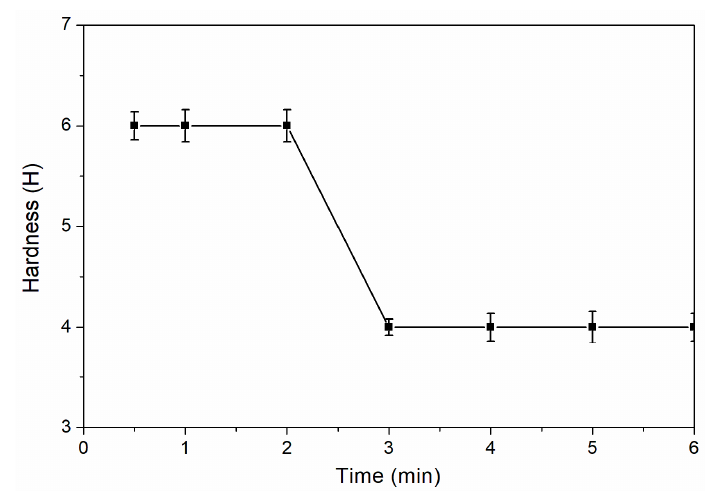
Figure 5. Effect of drying time on hardness of the coating.